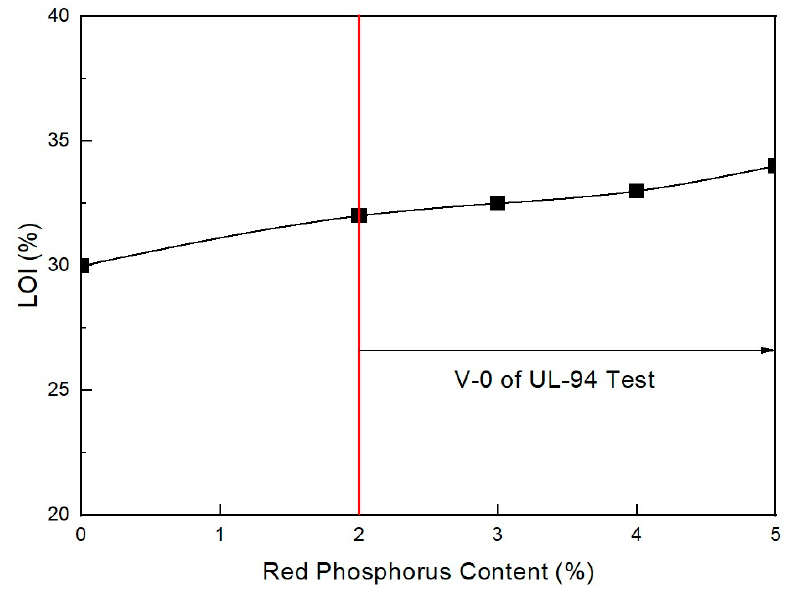
Figure 8. Flame retardancy of EVA/Tafmer DF805/CLNA ‐ 8400/EBM/120 phr flame ‐ retardant (MH+ZB) formulations as a function of additional RP content.